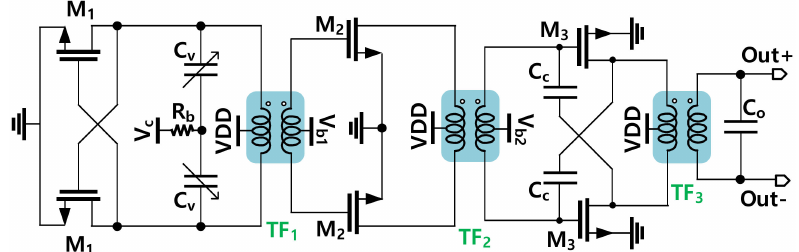
Figure 2. Schematic of the cross-coupled VCO with two buffer stages.